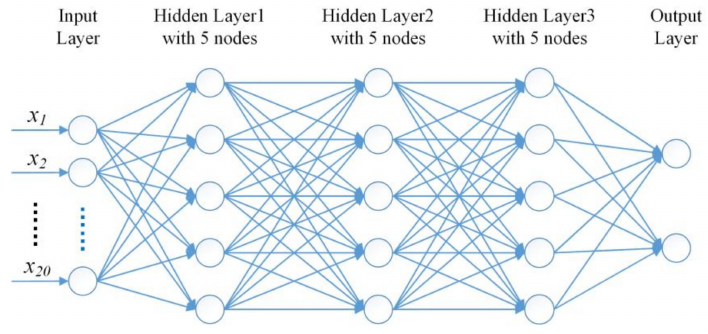
Figure 11. The architecture of the NN in this